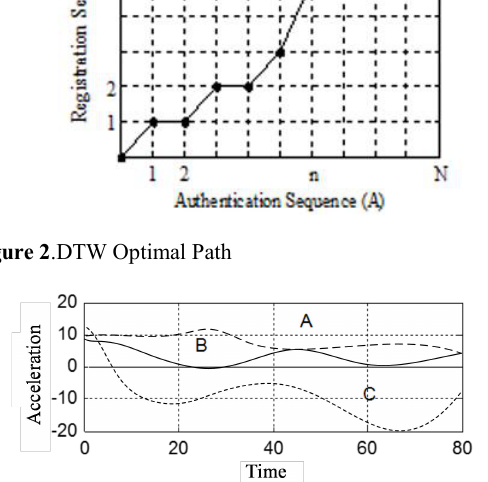
Figure 3 .Schematic Diagram of Morphological Weighted Euclidean